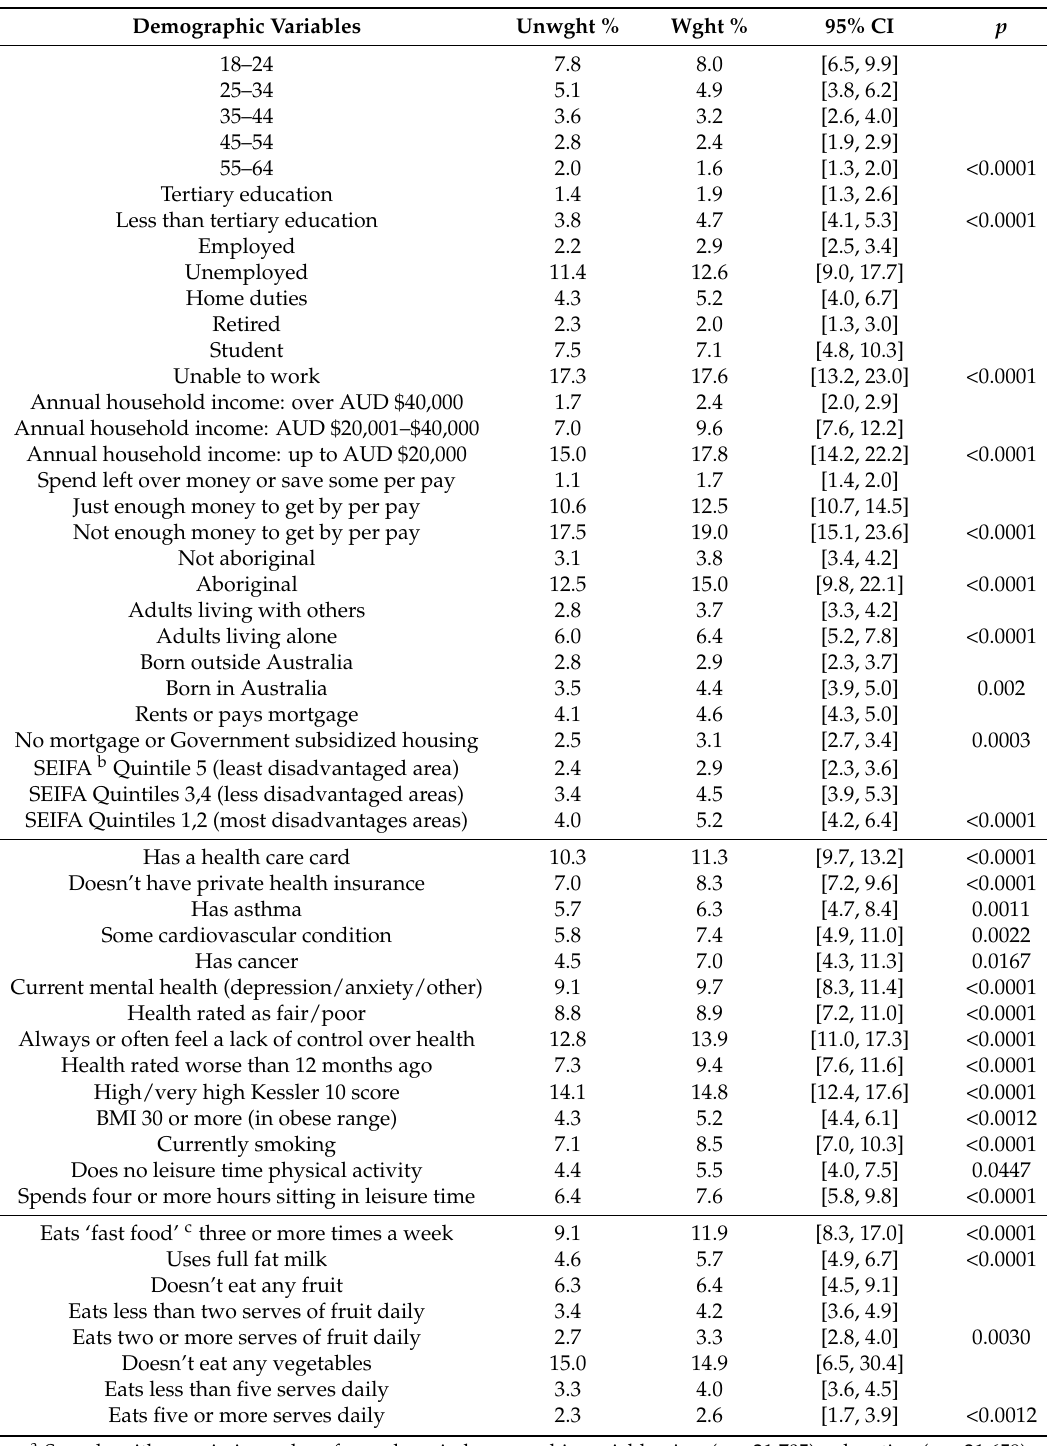
Table 1. The unweighted and weighted prevalences of ‘running out of food’ by sample characteristics, HWSS 2009–2013 (n = 21,705 a